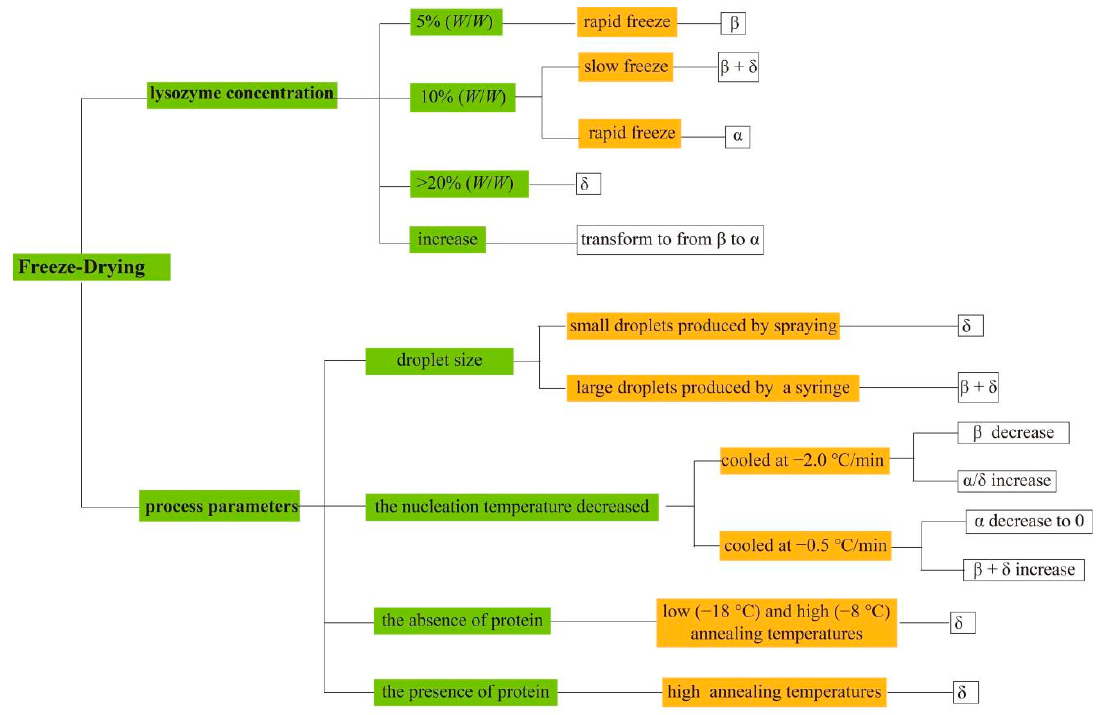
Figure 10. Schematic of freeze-drying method for the preparation of polymorphic mannitol.